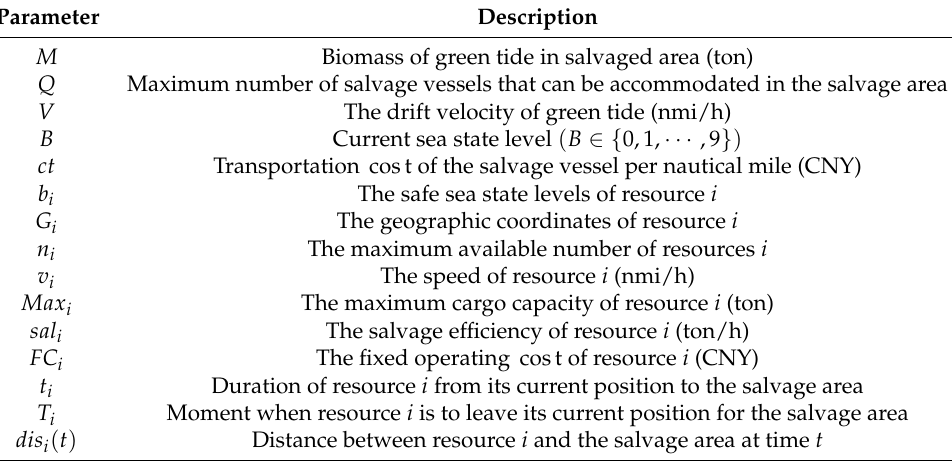
Table 1. Parameters of the